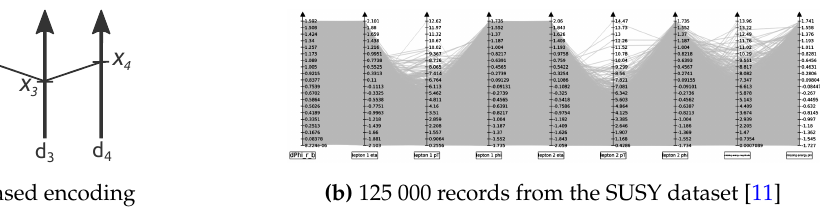
Figure 1. Traditional parallel coordinates. ( a ) Representation of a four-dimensional record X with a polyline ( b ) Example of clutter produced by the crossing and overlapping of many